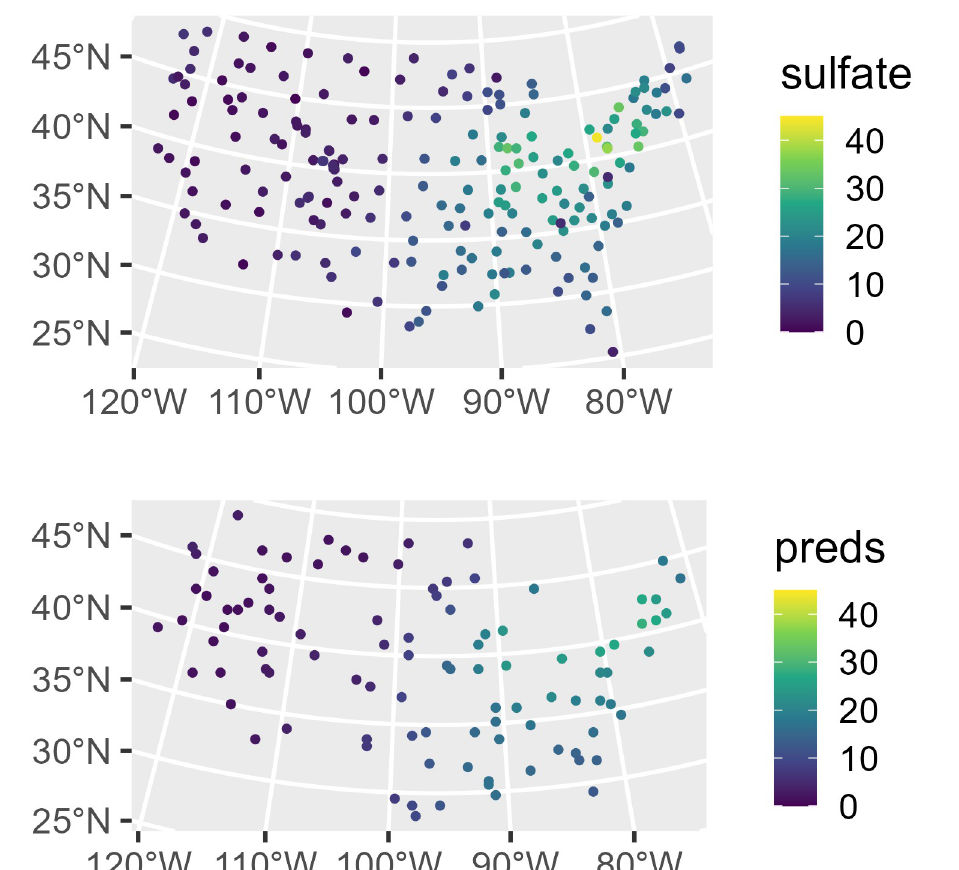
Fig 4. Distribution of observed sulfate and sulfate predictionsin the conterminous United States. In A (top), observed sulfate is visualized. In B (bottom), sulfate predictions are visualized.